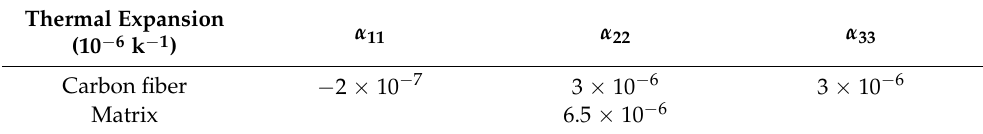
Table 4. The thermal expansion coefficients of components.